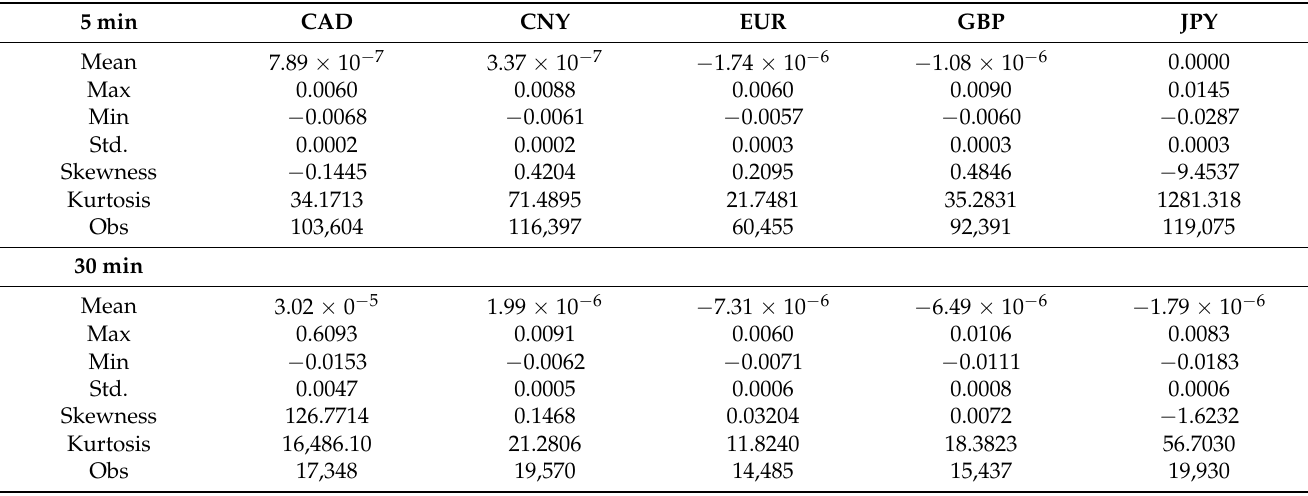
Table 1. Descriptive statistics of the currency returns with the American dollar as the base currency